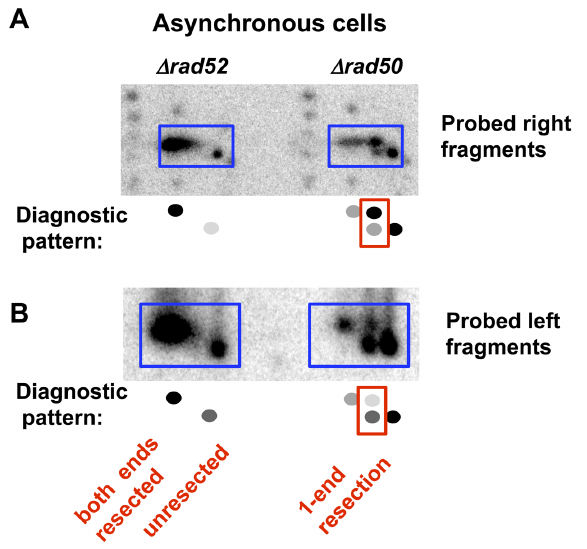
Figure 3. Resection at an I- Sce I-induced DSB in growing (asynchronous) D rad52 and D rad50 cells. 2-D PFGE analysis of resection of the right and left fragments after SfiI cutting. A. Right end probe (along with a small amount of labeled genomic probe to identify chromosome fragment positions on the gel). B. Left end probe (pure